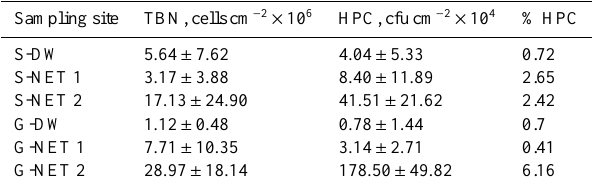
Table 2. Total bacterial numbers (TBN) and heterotrophic plate counts (HPC) in the biofilm samples.